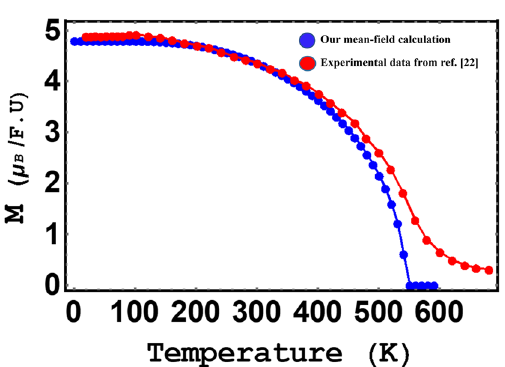
Figure 3. Total magnetization of YFe 3 in zero field vs.